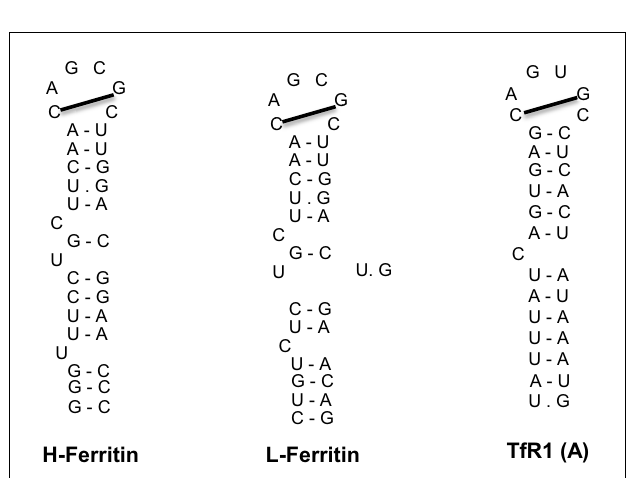
hepcidin promotes ferroportin degradation in lysosomes. Hepcidin expression is induced in response to high iron stores and inflammatory signals. Conversely, hepcidin expression is suppressed in response to iron deficiency and increased erythropoietic drive.